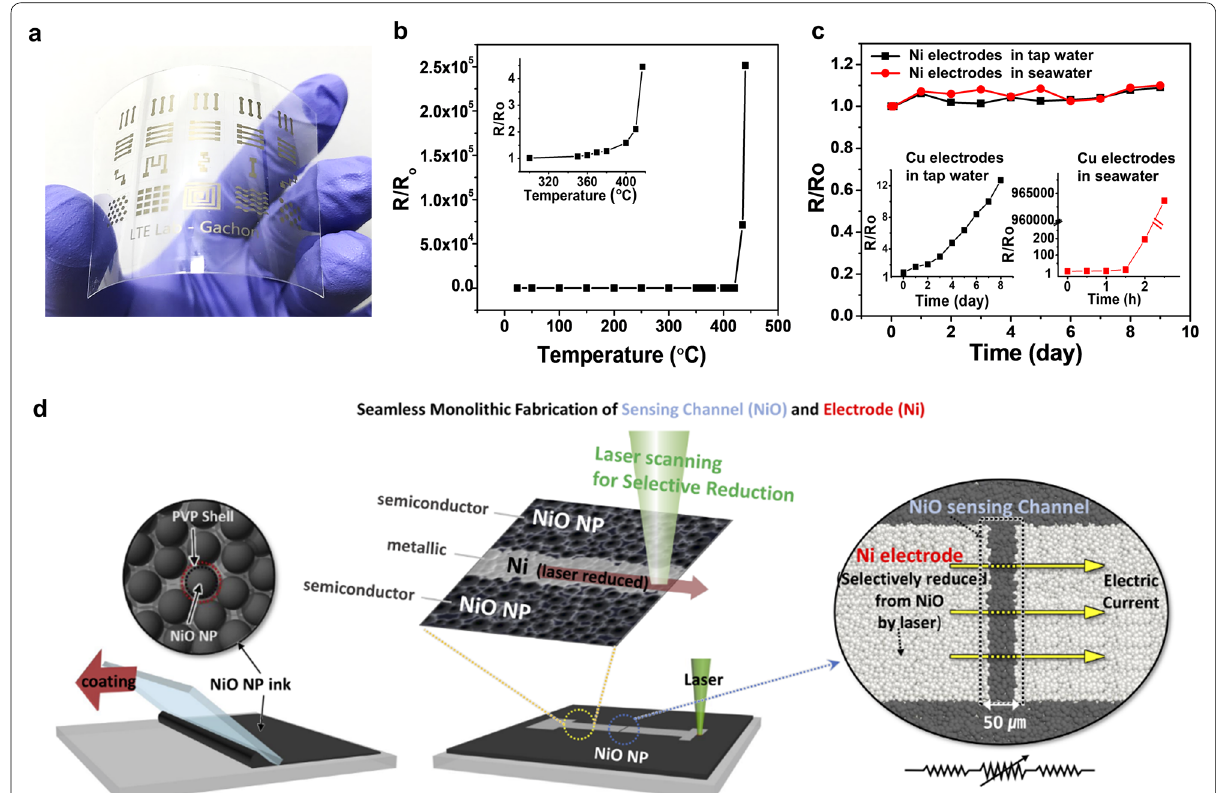
Fig. 8 a Customized Ni conductor patterns on a PET substrate. b Relative resistance variation (R/R o ) with an increase in the temperature from room temperature to 440 °C. The inset shows a magnified view in the temperature range of 300–420 °C. c Measured R/R o of Ni electrodes in tap water and seawater. The insets show the measured R/R o values of the Cu electrodes in tap water (left) and seawater (right) ( a – c reproduced with permission from Ref. [20]. Copyright Wiley–VCH, 2019). d Schematic of the monolithic LRS process. NiO NP ink is coated on a substrate via the doctor blading technique. Selective laser irradiation of the dried NiO layer using a computer-aided galvano-mirror system and a monolithic Ni-NiO–Ni structure having a NiO-channel (several tens of micrometers wide) formed via the simple hatching technique ( d reproduced with permission from Ref.